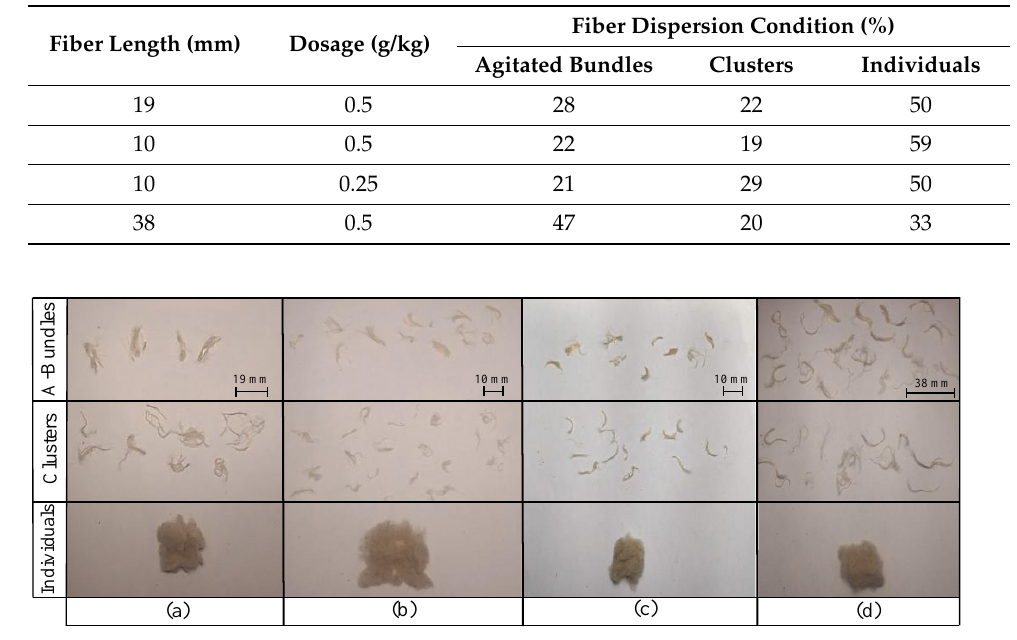
Figure 5. Relative amounts of recovered aramid fibers for ( a ) 19 mm (0.5 g/kg), ( b ) 10 mm (0.5 g/kg), ( c ) 10 mm (0.25 g/kg), and ( d ) 38 mm (0.5 g/kg).